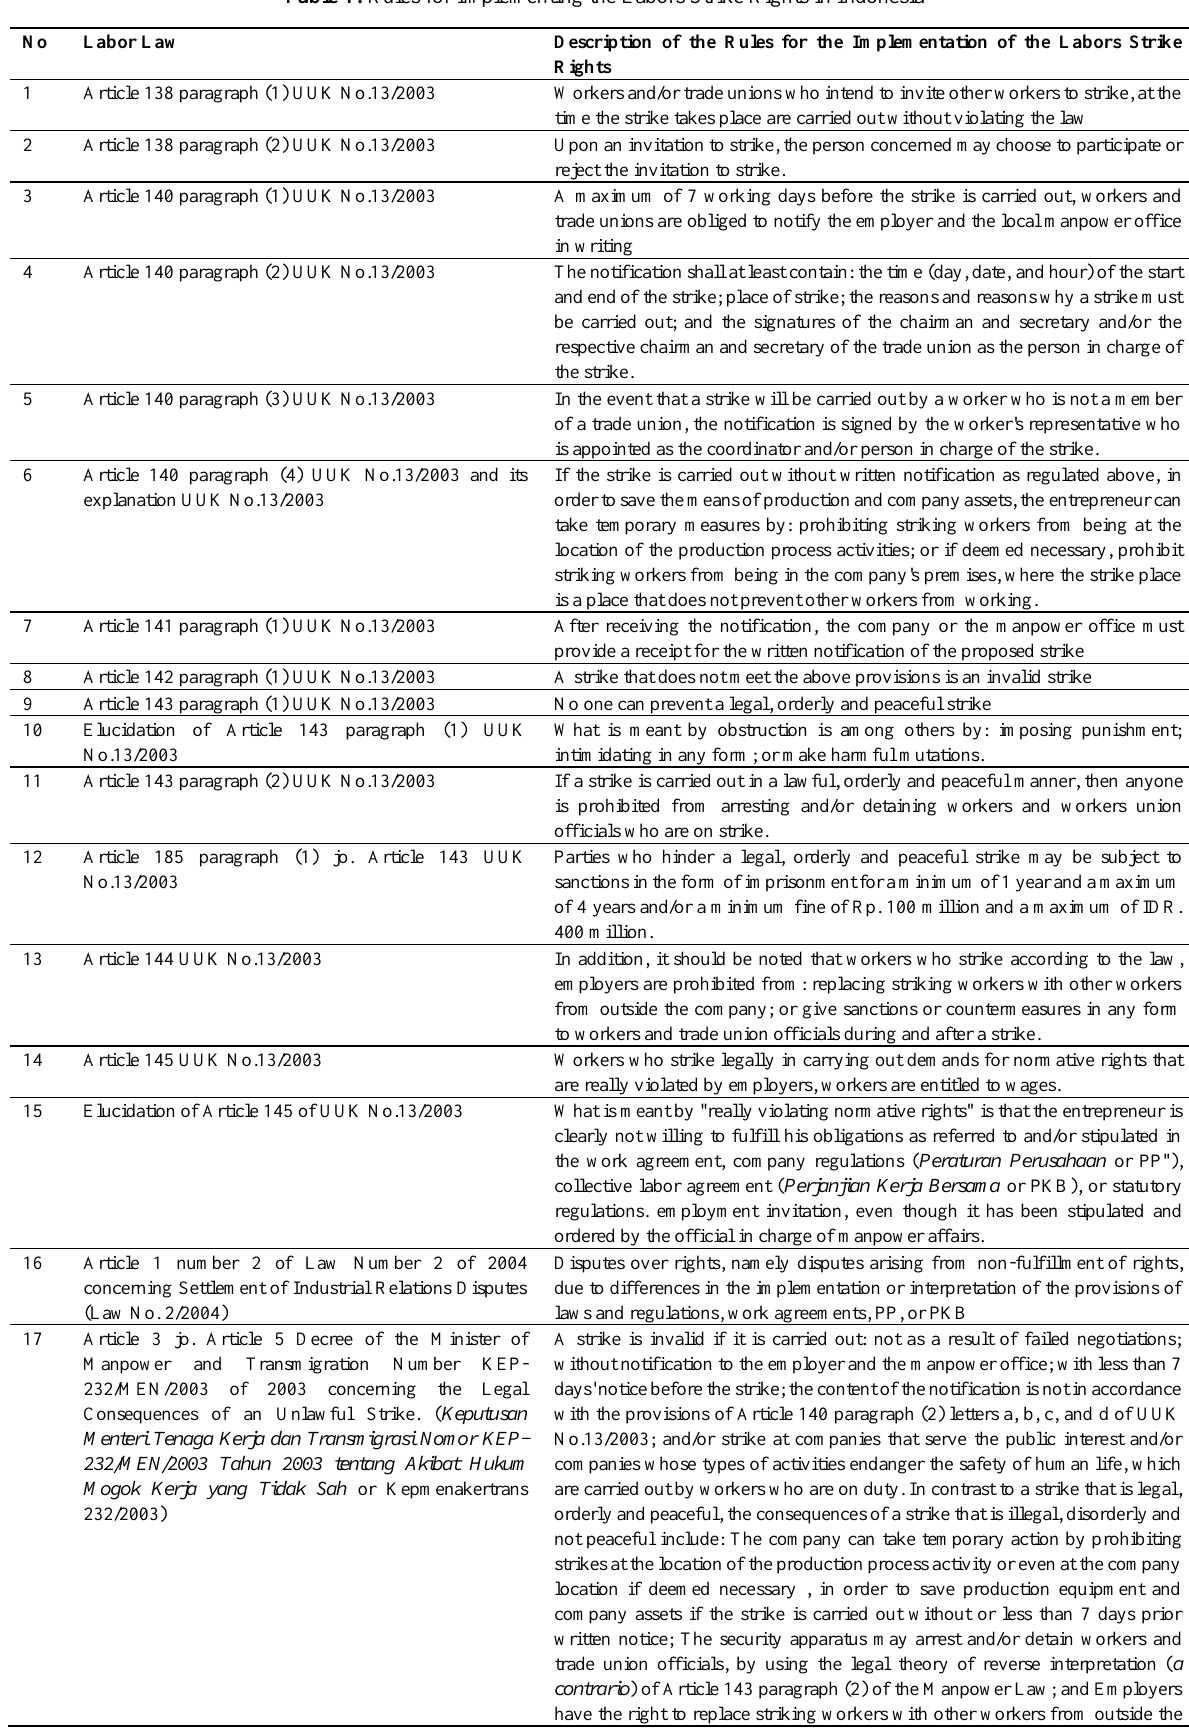
Table 1: Rules for Implementing the Labors Strike Rights in